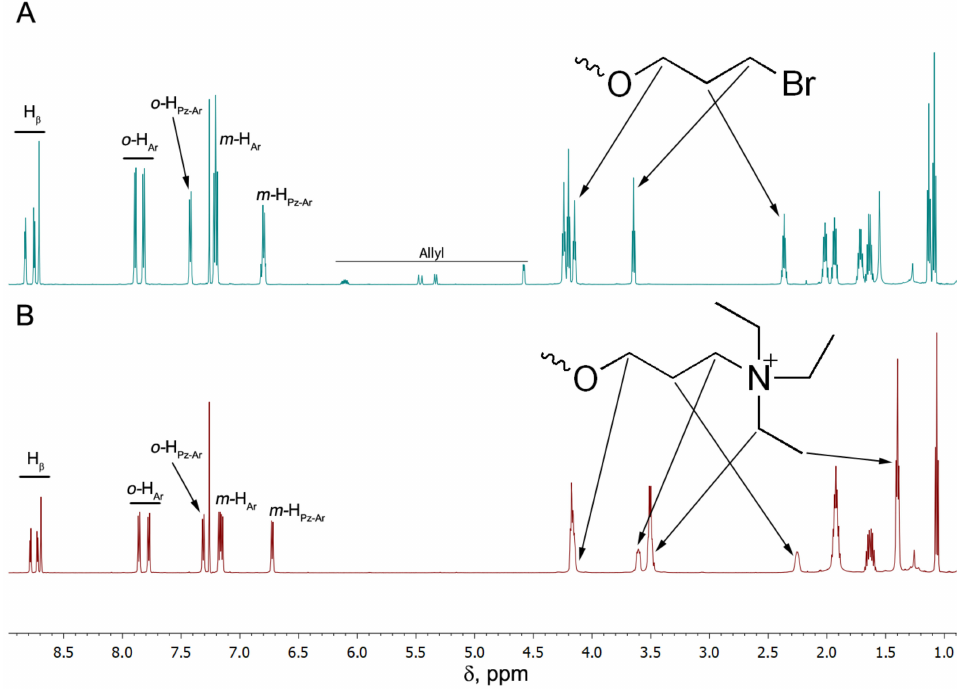
Figure 2. NMR spectra of Ni-3 ( A ) and Ni-1 ( B ) in CDCl 3